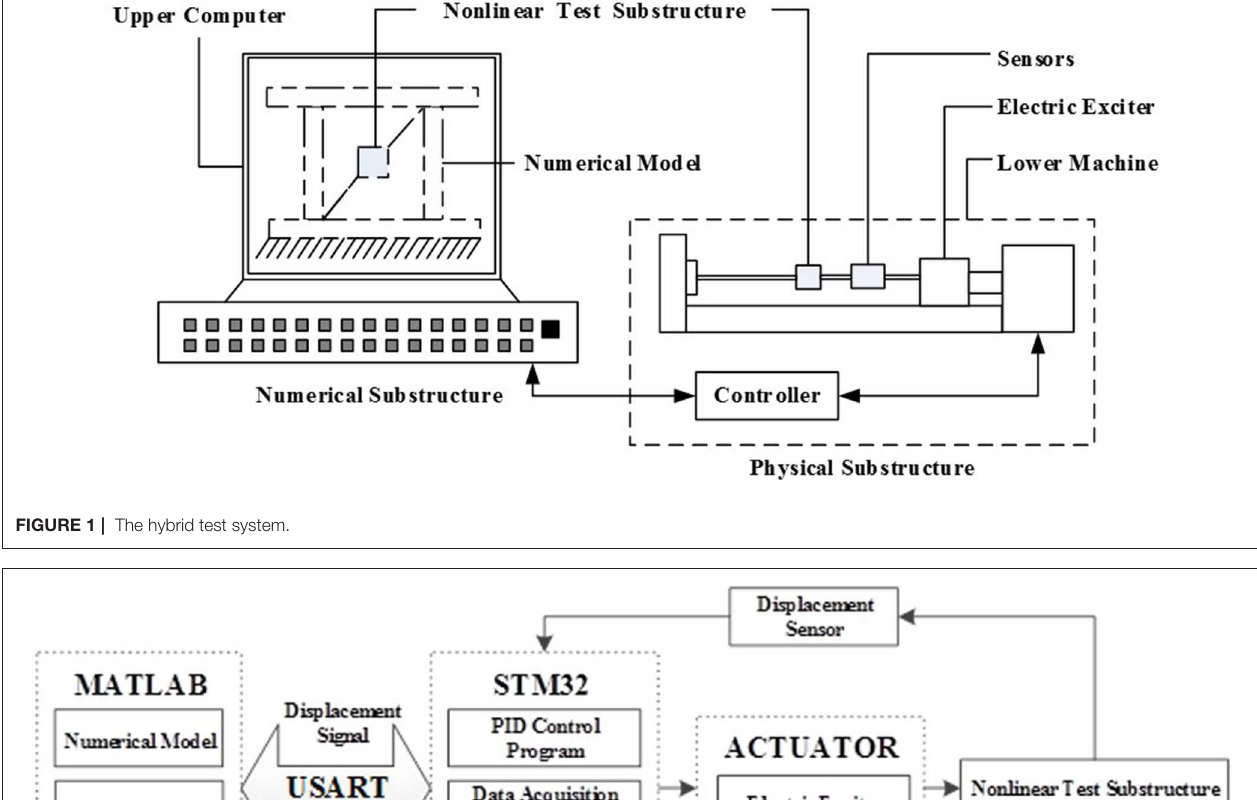
FIGURE 2 | The detail design scheme diagram of the hybrid test